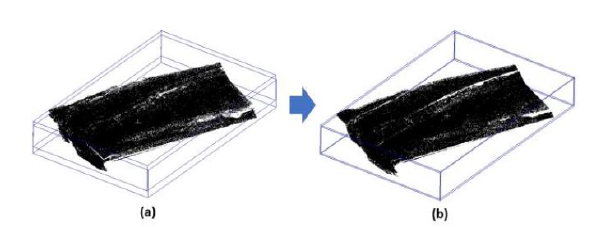
Figure 7 . MBBC process (Ahmad Fuad et al., 2018)